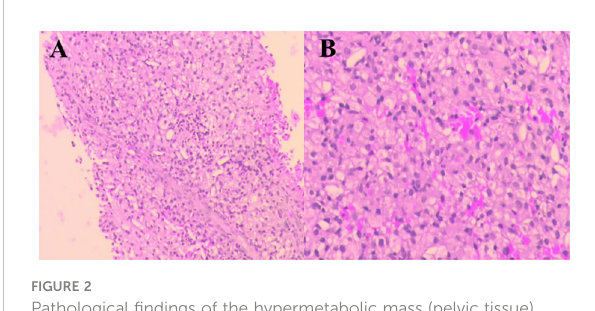
FIGURE 2 Pathological fi ndings of the hypermetabolic mass (pelvic tissue). Hematoxylin and eosin (H&E) staining. Original magni fi cation: (A) ×40. (B)